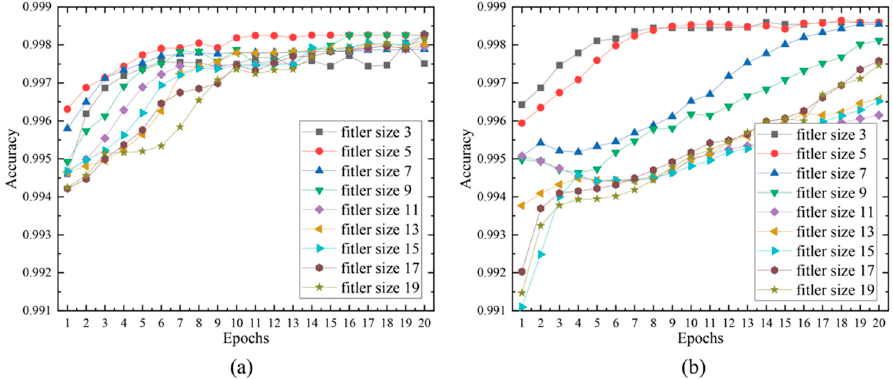
Figure 4. Results of using the SCDA model on the yeast data. ( a ) The results of the five-layered SCDA with filter sizes ranging from 3 to 19. ( b ) The results of the five-layered SCDA with filter sizes ranging from 3 to 19.